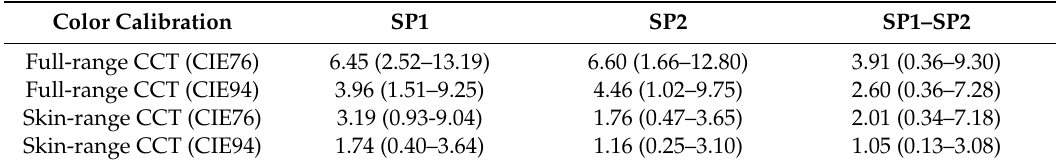
Figure 4. Mean CIE76 color differences ( ΔE ) with standard deviations as error bars for the full-range or skin-range CCT, obtained from the six image sets which were acquired by the first (SP1, Nokia) or second (SP2, Samsung) smartphone, respectively. SP1–SP2 marks the color differences between both smartphones’ estimates.